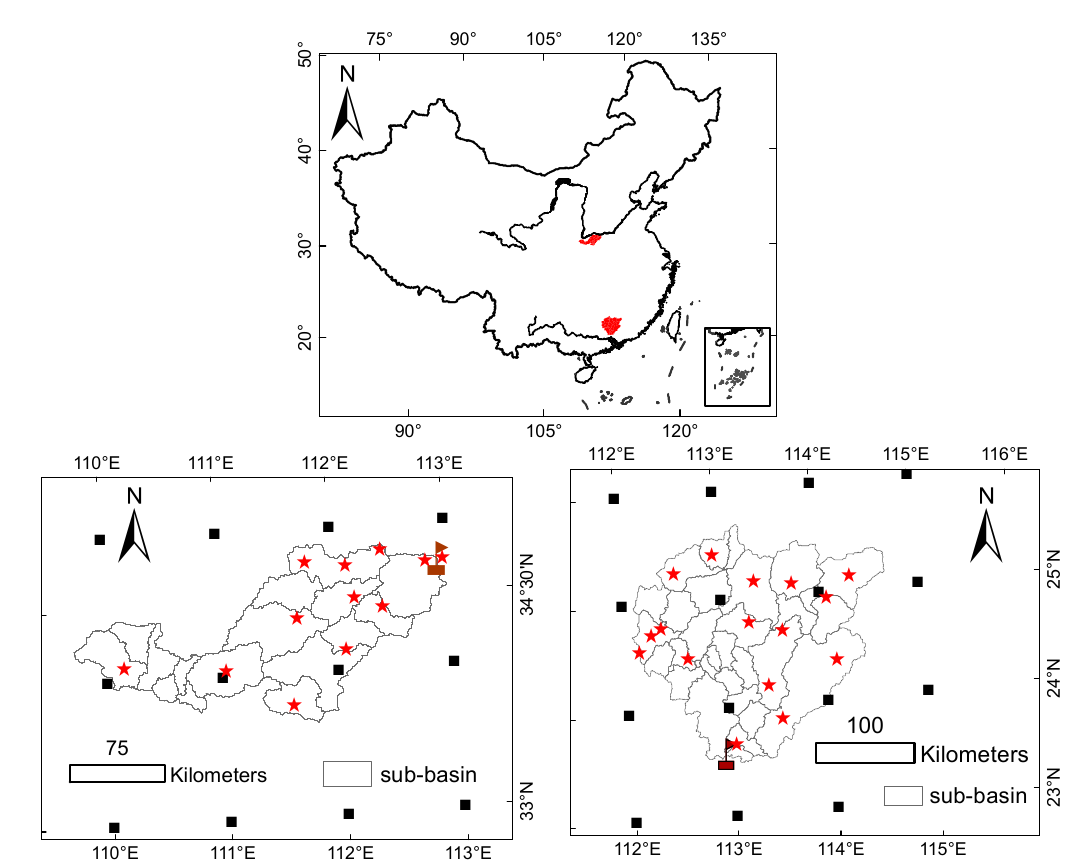
Figure 1. ( Upper ) Locations of the Yiluo and Beijiang rivers in China. Hydrological stations (dark red flag), climate stations (red star), grid notes of the dynamic extended-range forecast (DERF2.0) (black square) as well as sub-basins division of the ( lower left ) Yiluo River and ( lower right ) Beijiang